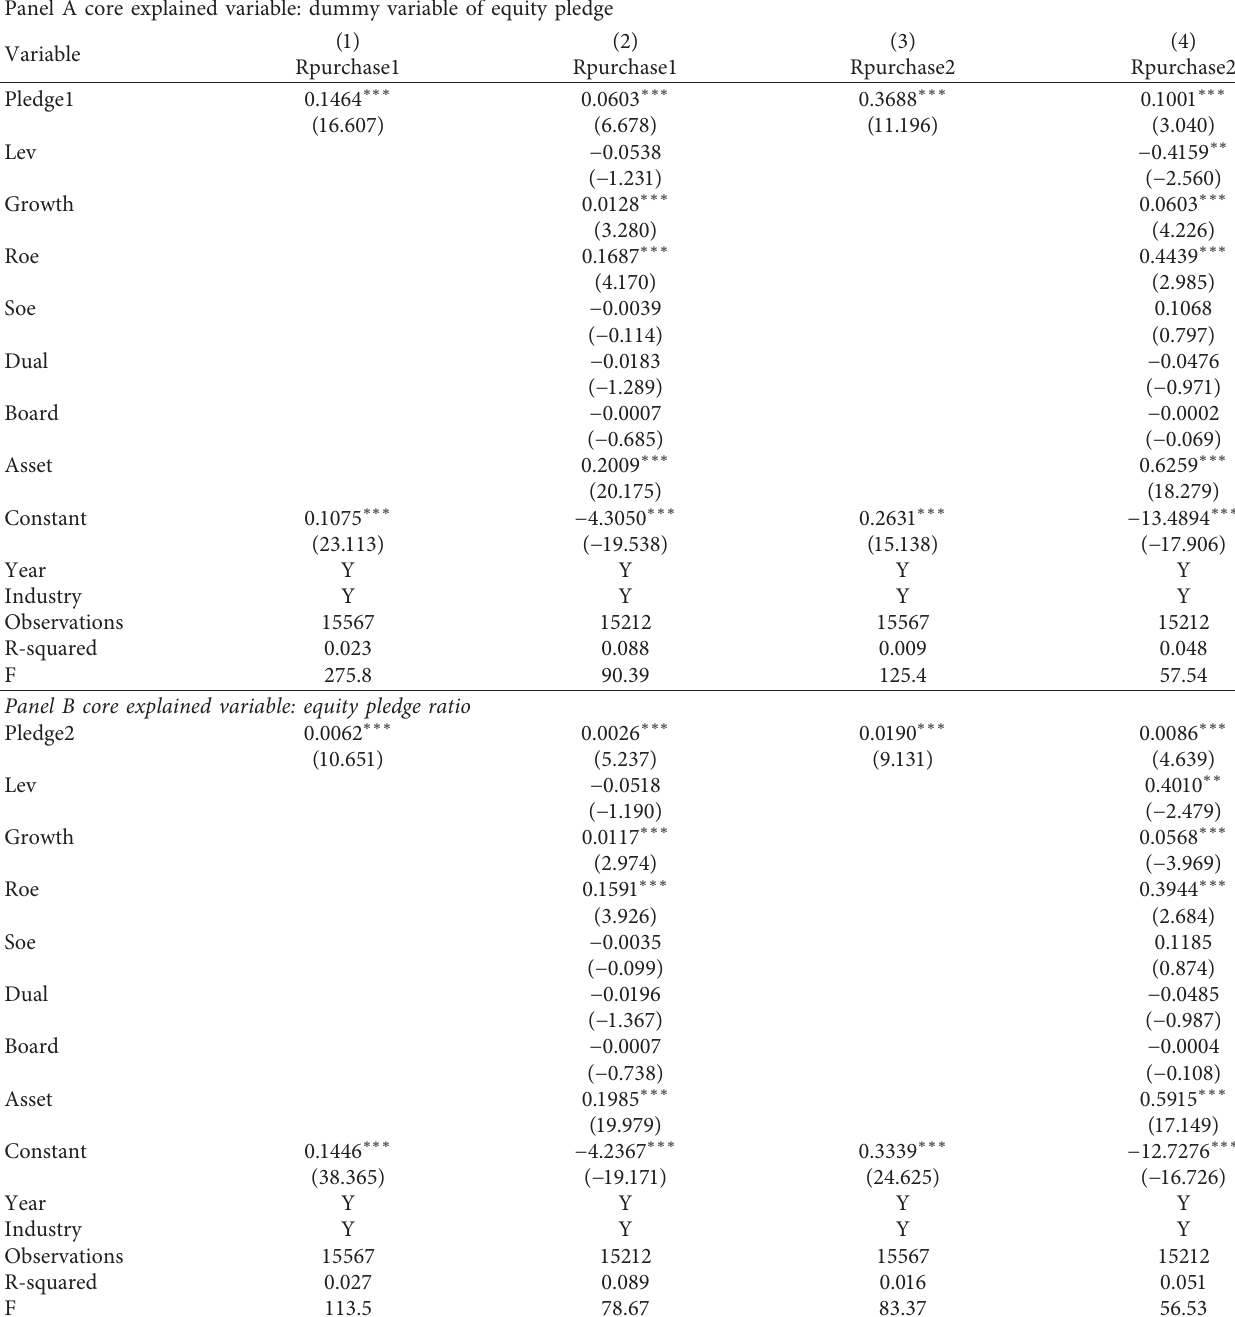
Table 4: Results of baseline